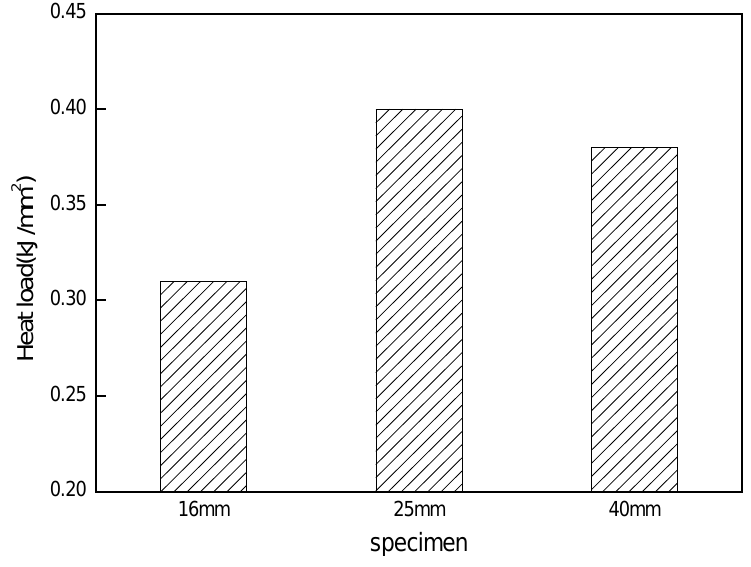
Figure 5. Welding heat load.